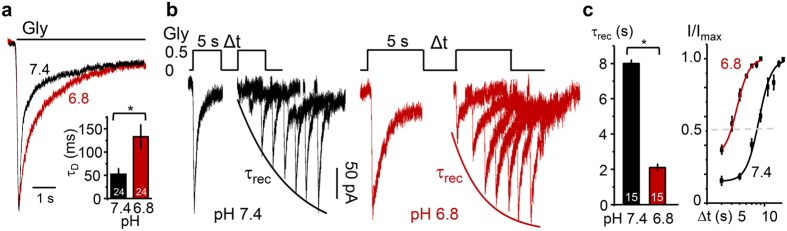
Protons alter GluN1/GluN3A desensitisation kinetics.(a) Glycine-elicited currents recorded at pH 7.4 (black) and pH 6.8 (red) superimposed and normalized to peak; bar graph summarizes changes in the weighted desensitisation time course (τD). (b) Glycine double-pulse current traces elicited at pH 7.4 and pH 6.8; Δt was 3 s with 2 s increments for pH 7.4, and 3 s with 1 s increments for pH 6.8; curves represent exponential fits to average Ipk values. (c) Summary data for time constant of recovery from desensitisation (τrec) (left) and time-dependence of peak current (Ipk) recovery from desensitisation (right). Values are means ± SEM, sample size is in bars; *P < 0.05.